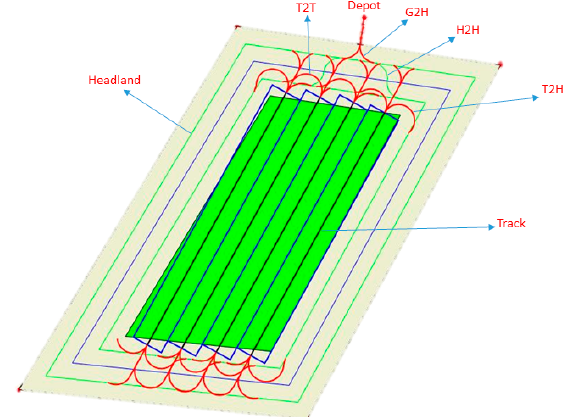
Figure 2. Tracks generation and edges type.